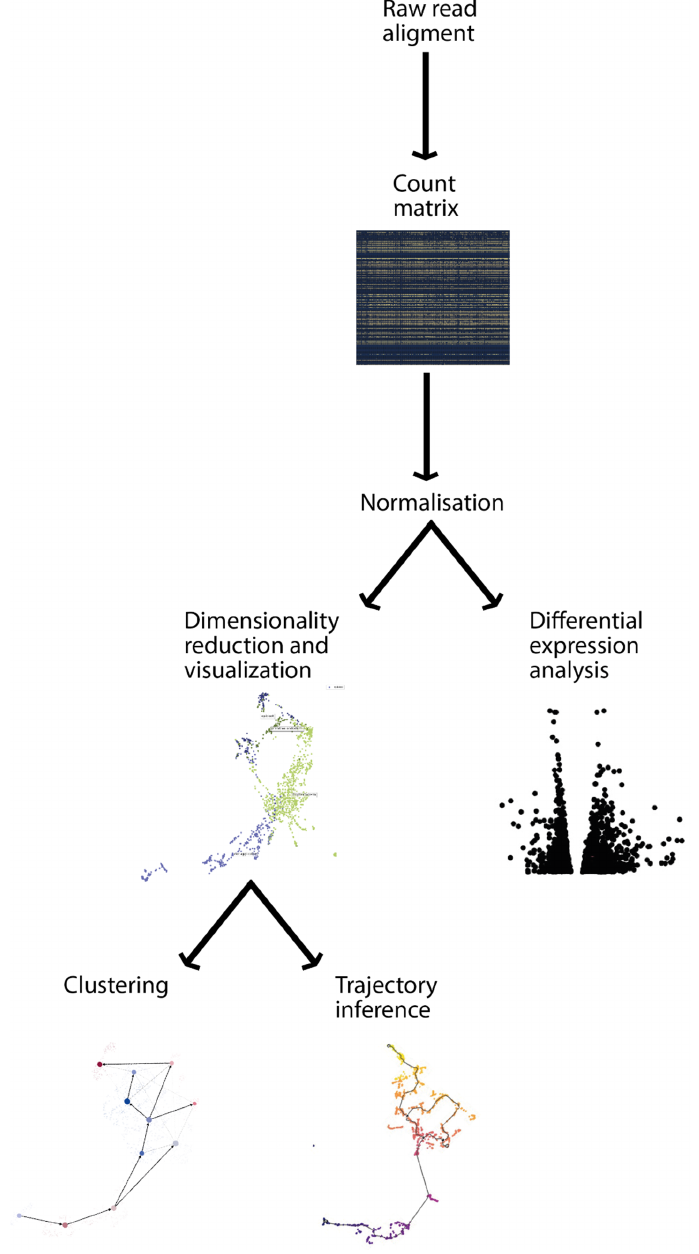
Figure 2. Transcriptomic analysis pipeline. Starting from the raw read alignments, several steps are needed to obtain concrete biological results, such as the identification of differential expressed genes or cluster marker genes. The first step is to align gene sequences to a gene annotation reference to be able to count the number of reads for each gene. This will allow us to obtain a count matrix, which can be used for differential expression analysis, identifying genes that are significantly changed (up/down regulated) in certain conditions and visualising them for example in a volcano plot. In parallel, the dimensions of the count matrix can be reduced and visualised with several techniques (i.e., PCA, t-SNE, and UMAP). This allows to identify clusters and, in the context of single-cell experiments, also to infer developmental